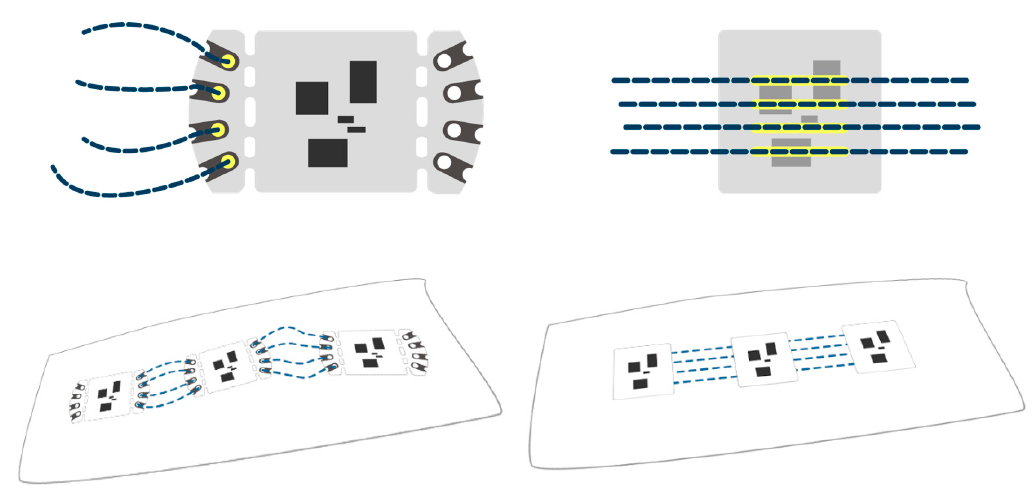
Figure 3. Two possible connection methods for the toolkit: ( Left ) manually attached modules connected through outer vias using hand-sewn conductive thread. ( Right ) Miniaturized modules, contacted to textile-integrated conductive tracks using textile